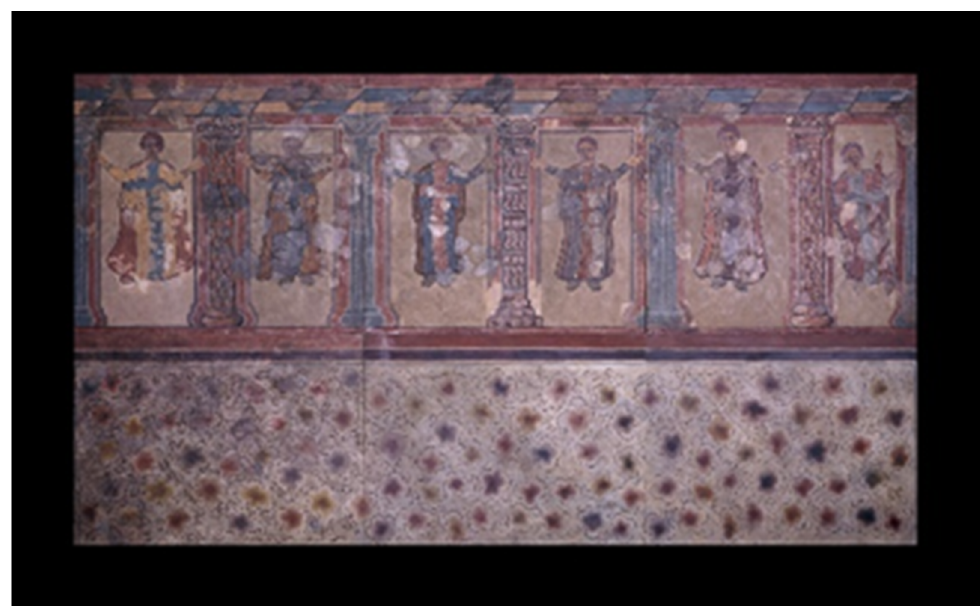
Figure 18. Wall painting from Villa at Lullingstone, Kent, England, 4th century CE. Romano-British. Length: 420 cm (165 3/8 in.). The British Museum, 1967,0407.1.b © The Trustees of the British Museum. Shared under a Creative Commons Attribution-NonCommercial-ShareAlike 4.0 International (CC BY-NC-SA 4.0) license.